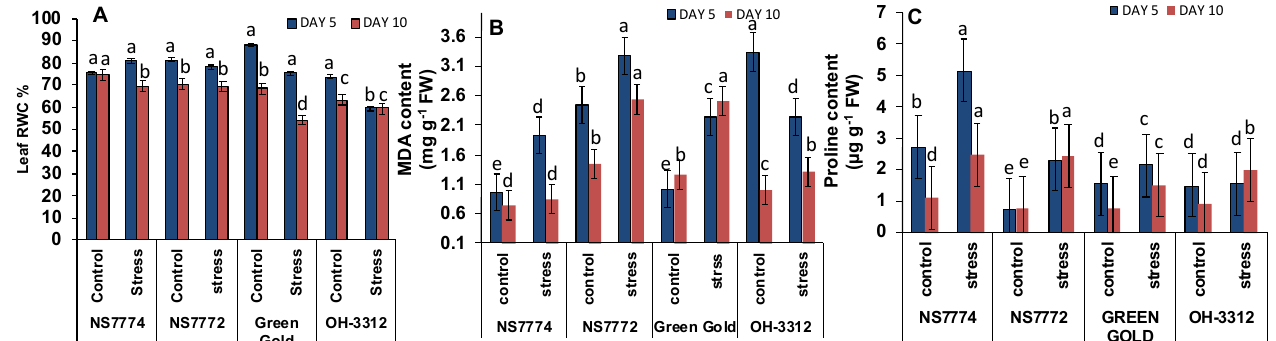
Figure 3. Changes in ( A ) relative water content, ( B ) Malanoaldehyde content, and ( C ) proline content, as affected by drought stress at 5 and 10 days of interval in okra genotypes NS7774, NS7772, Green Gold, and OH3312, along with respective controls. Vertical bars indicate mean ± SE for n = 5. Means denoted by the different letter are significantly different at p ≤ 0.05 according to the Tukey’s studentized range test.